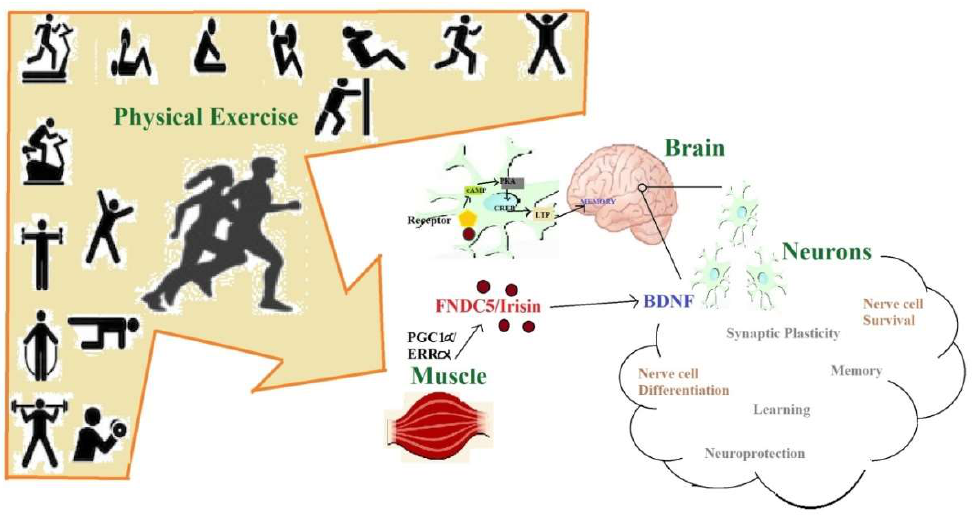
Figure 2. E ff ect of physical exercise (PE) on neurons involving brain-derived neurotrophic factor BDNF and irisin.